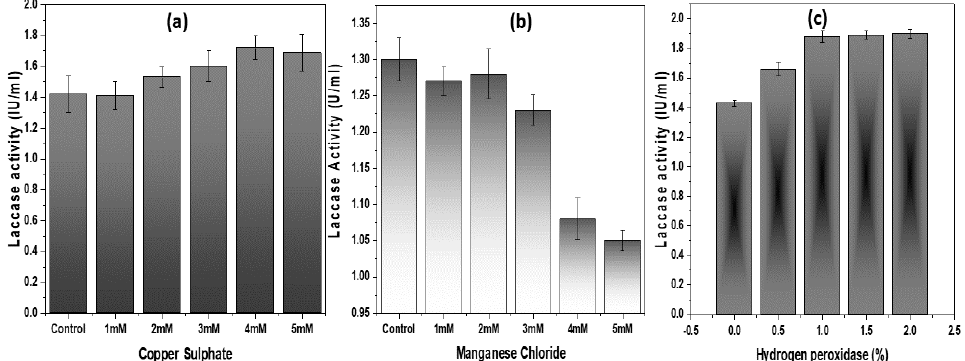
Figure 3. Effect of ( a ) Copper (Cu), ( b ) Manganese (Mn), and ( c ) hydrogen peroxidase on laccase induction in Geobacillus sp. strain WSUCF1 with 0.5% (w/v) unprocessed corn stover (CS) and 0.025% (w/v) kraft lignin, at 60 °C, pH 7.0, and agitation speed of 150 rpm, after 10 days of incubation. Here, IU = International Units. Note: All the experiments were performed in triplicates, with data averaged and presented as the mean ± standard deviation (SD).